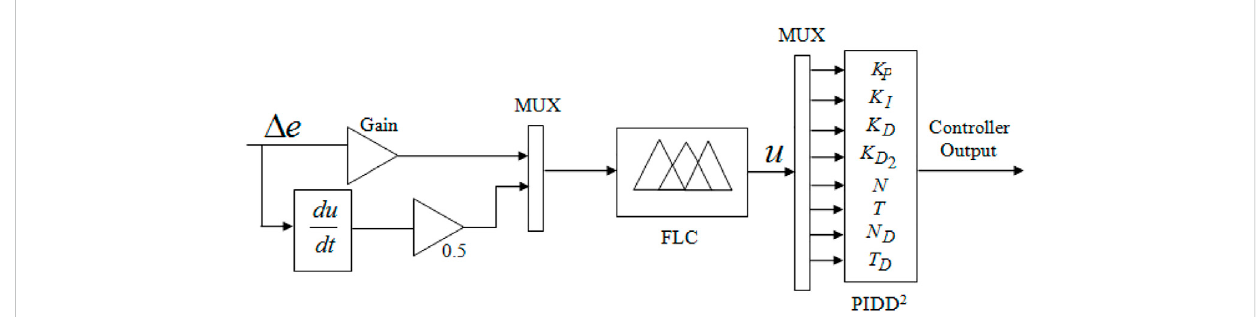
FIGURE 2 Fuzzy-based PIDD 2